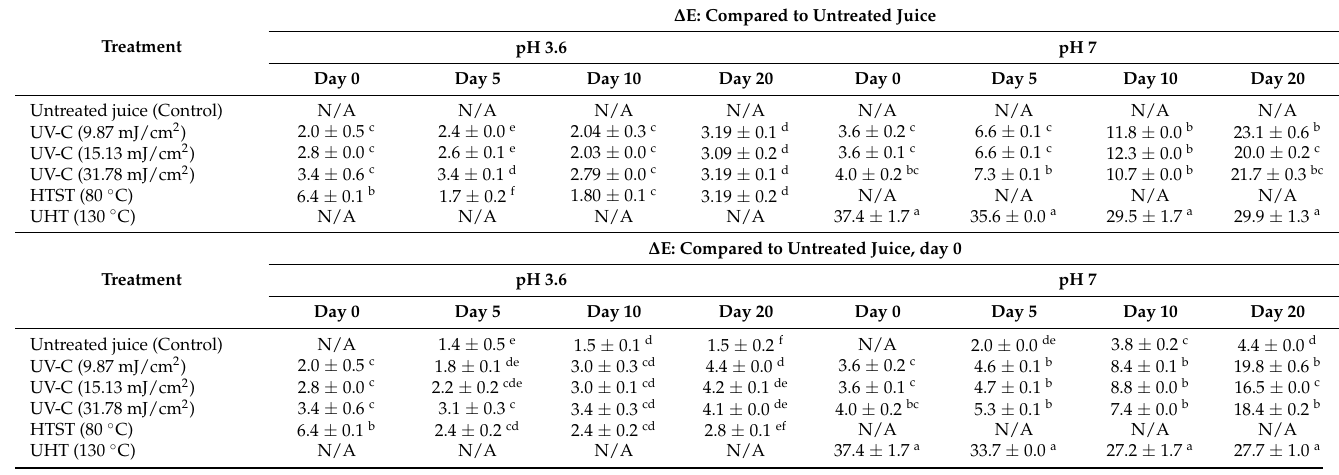
Table 6. Effect of UV-C irradiation and thermal treatment on color parameters of color difference ( ∆ E) of red prickly pear